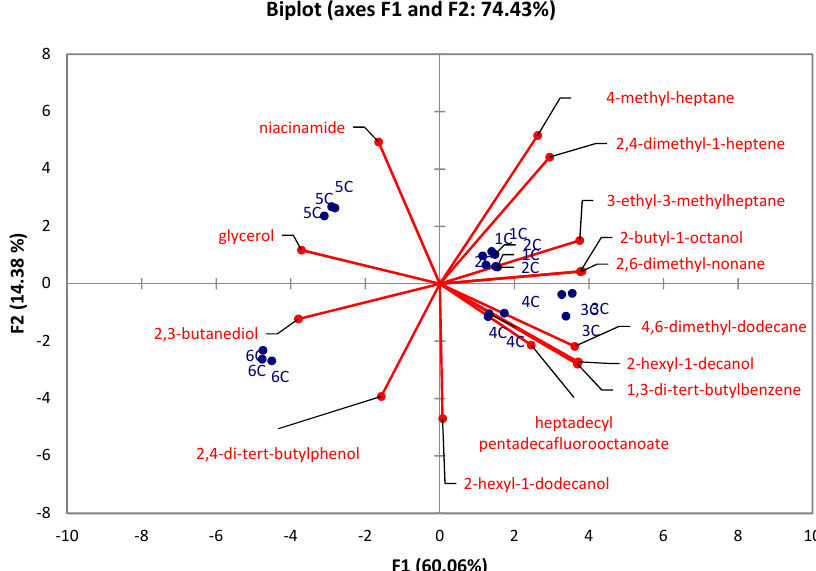
Figure 3. PCA evaluation of six developmental stages (1C–6C) of A. rubescens Pers caps.